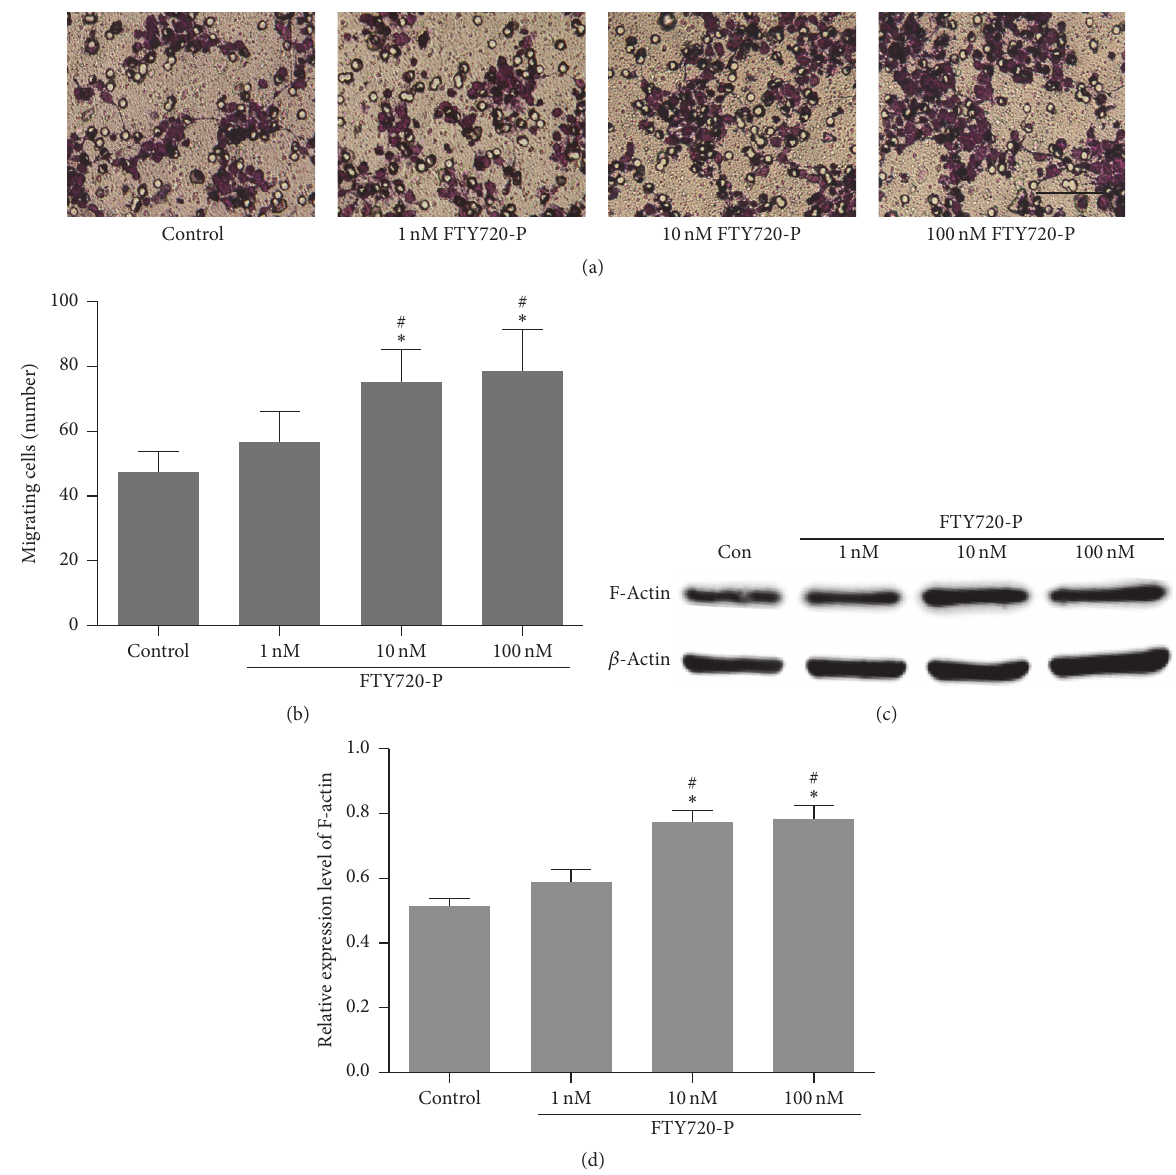
Figure 5: Quantification analysis of migrated cell numbers with FTY720 intervention. ((a)-(b)) Number of migrated cells from upper Boyden Chamber with crystal violet staining (bar = 100 𝜇 m). Migrated cells were counted by crystal violet staining and averaged three random microscope fields of each sample; five independent experiments were done. ((c)-(d)) Relative expression level of F-actin among groups. Mean ± SD and 𝑛 = 5 in each group. ∗ 𝑃 < 0.05 compared with control group; # 𝑃 < 0.05 compared with 1nM FTY720 group, by ANOVA followed by Dunnett’s multiple comparison